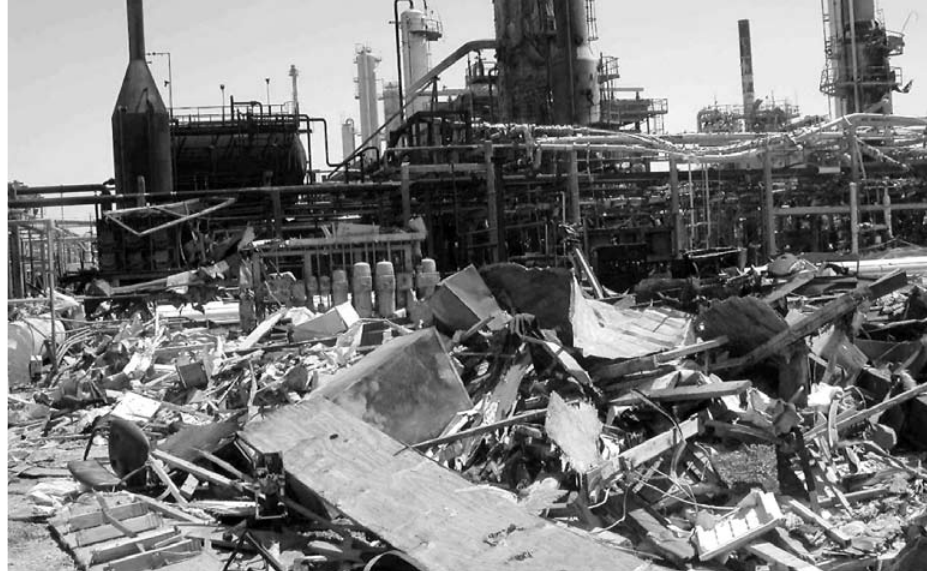
fig. 3. Explosive damage to technological piping (top-right side of the picture; BP Texas City explosion March 2005) (CSHIB